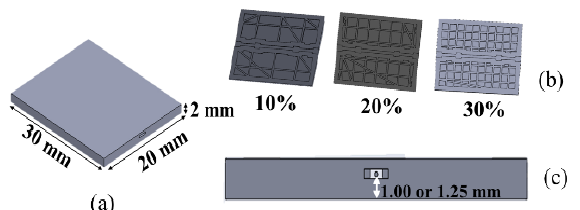
Fig. 1: Schematics of the sensor: (a) general dimensions (b) the infills; (c) the height of the FBG in the